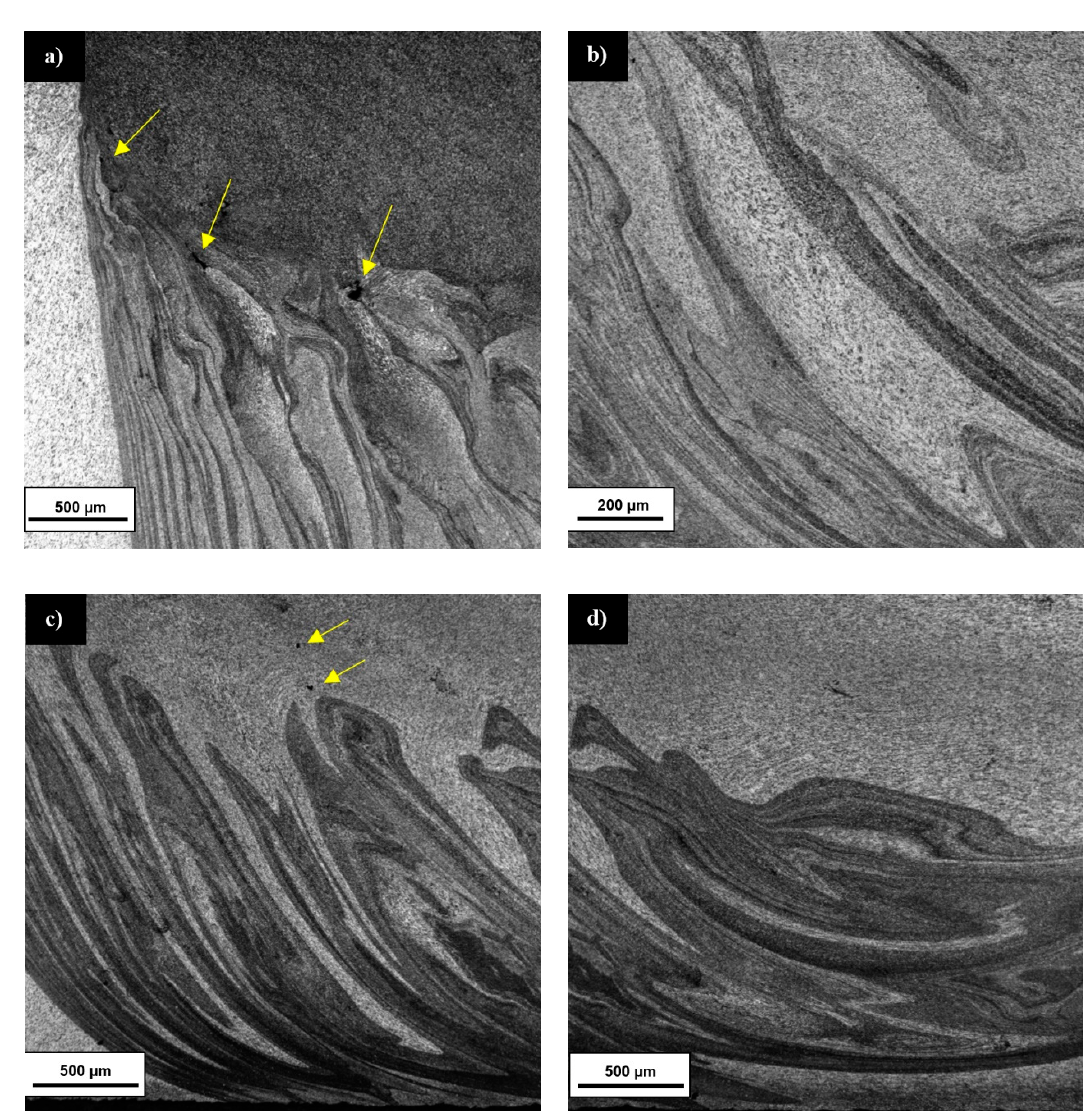
Figure 3. Light microscopy image of ( a ) voids in the A88 sample, ( b ) bands in the A88 sample, ( c ) bands in the A44 sample, and ( d ) stir zone of the A44 sample. Voids are indicated by yellow arrows.